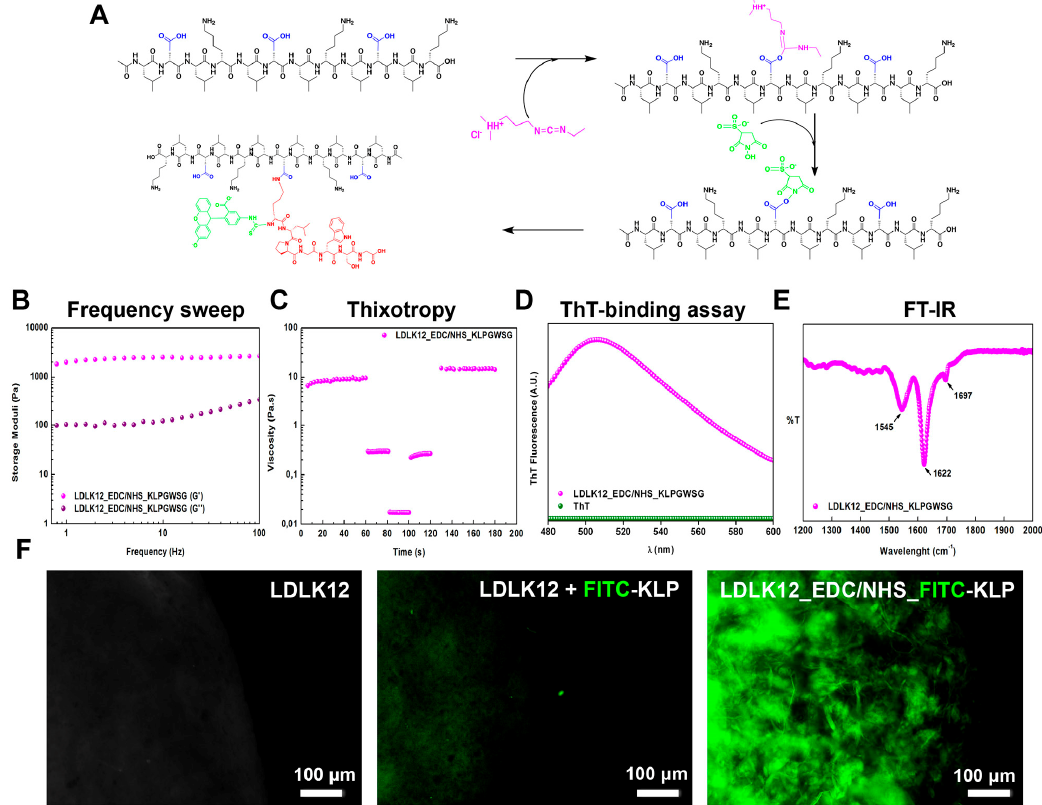
Figure 5. Post-assembly functionalization of KLPGWSG peptide. ( A ) Reaction scheme of the EDC / sulfo–NHS-mediated conjugation of fluorescein isothiocyanate (FITC)-KLPGWSG to LDLK12. The LDLK12 peptide is shown in black, FITC-KLPGWSG is shown in red, the carboxyl group is shown in blue, EDC is shown in magenta, and sulfo–NHS is shown in light green. ( B ) Dynamic frequency sweep of phage-derived KLPGWSG conjugated to the surface of LDLK12 peptides, recorded as a function of angular frequency (0.1–100 Hz) at a fixed strain of 1%; ( C ) thixotropy test of KLPGWSG post-assembly functionalized LDLK12; ( D ) ThT-binding assay showing a typical amyloid-binding emission signal (ThT alone was used as blank); ( E ) FT-IR spectrum of the LDLK12 peptide after the EDC / sulfo–NHS reaction with KLPGWSG showing a predominant β -sheet secondary structure; and ( F ) fluorescence micrographs of LDLK12 nanofibers reacted with FITC-KLPGWSG. Standard LDLK12, as well as LDLK12 and FITC-KLPGWSG without EDC / sulfo–NHS conjugation, were used as controls.